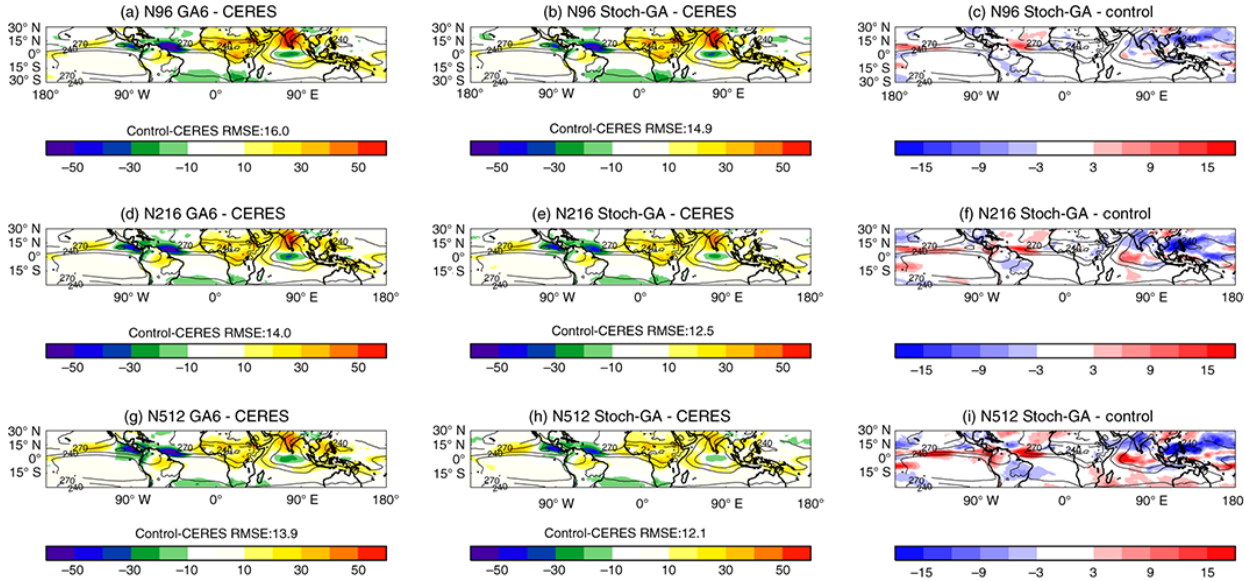
Figure 11. Mean June–August (JJA) top-of-atmosphere outgoing LW radiation (OLR) errors (Wm − 2 ) from 20-year atmosphere/land-only climate simulations compared to Clouds and the Earth’s Radiant Energy System (CERES) Energy Balanced and Filled (EBAF) dataset (Loeb et al., 2009). The columns from left to right are GA6.0 controls, GA6 plus the stochastic physics package (labelled Stoch-GA) and the difference between the two, whilst the rows from top to bottom are from simulations at N96, N216 and N512 resolution. This figure is reproduced from Sanchez et al.